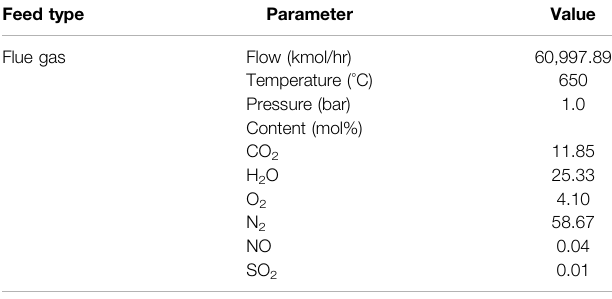
TABLE 5 | Carbonator reactor ’ s feed information (single process line).